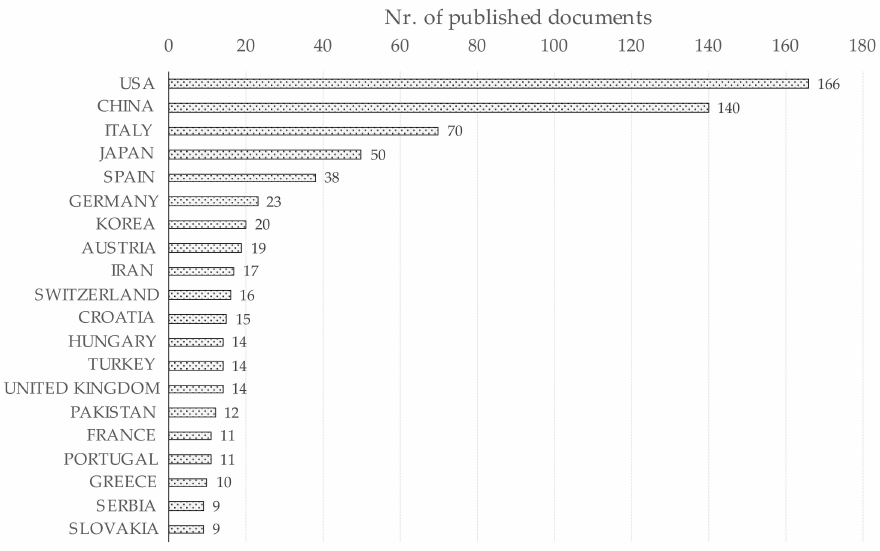
Figure 5. List of countries that contribute most to the publication of documents on the topic A. altissima .